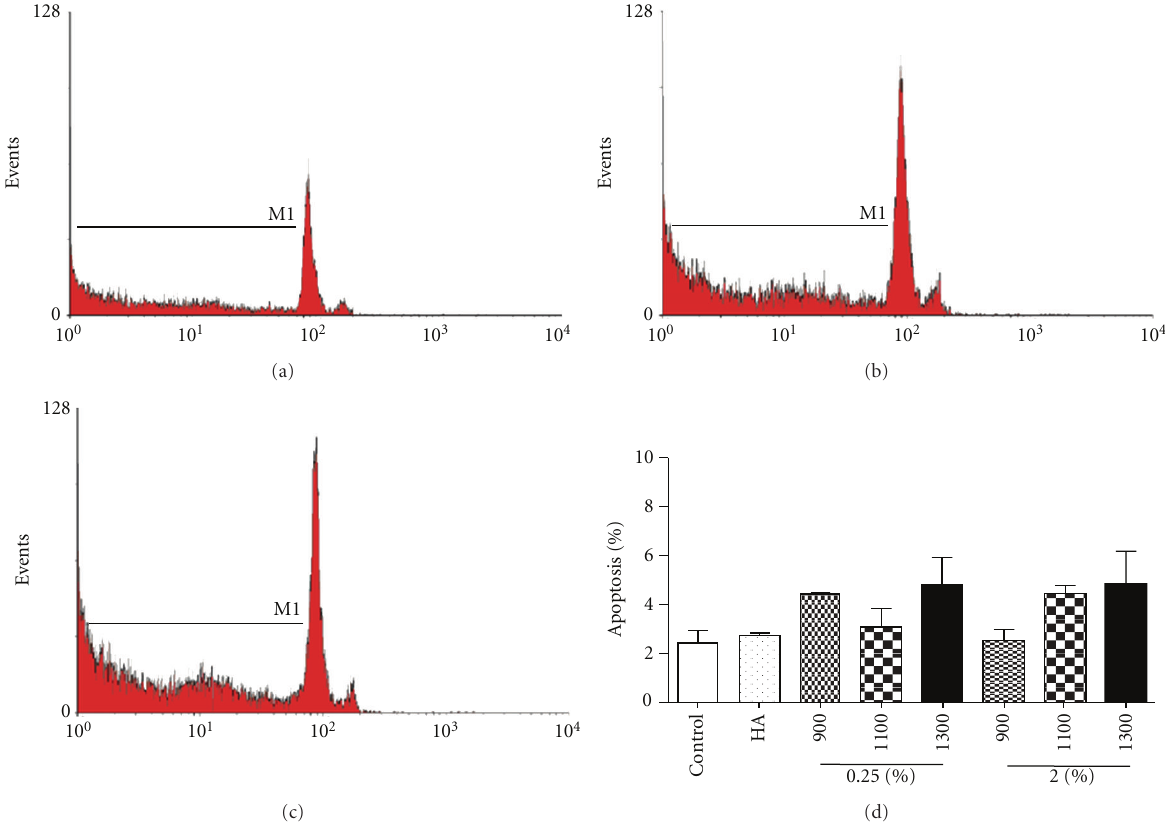
Figure 4: Flow cytometry analysis of apoptotic cells. (a–c) Representative histograms, the M1 marker represents the subdiploid content. (a) Control, (b) Commercial hydroxyapatite, and (c) LiHA sample. (d) Graphic summarizing the percentage of death cells. The results are expressed as the means ±